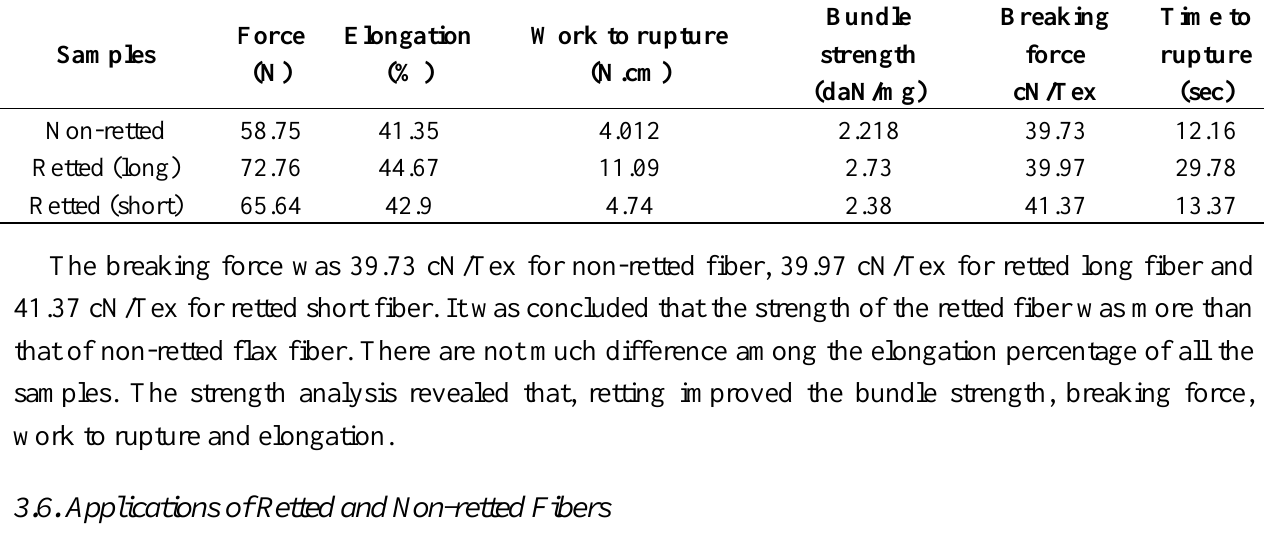
Table 3. Strength test result comparison of retted and non-retted